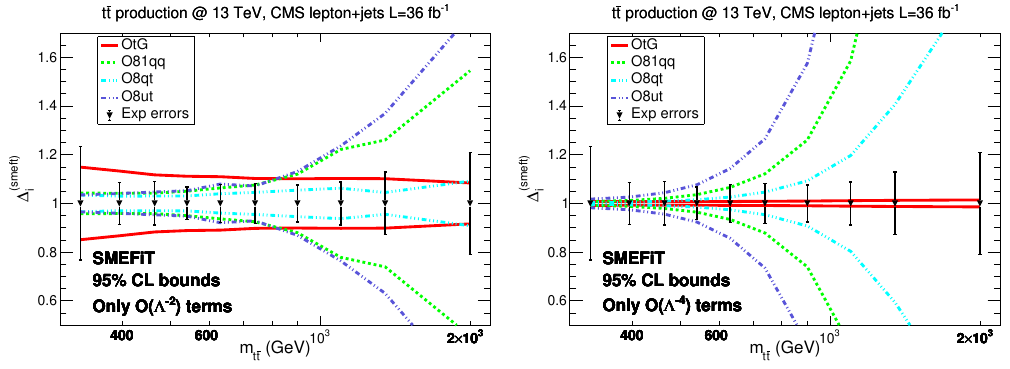
Figure 23 . The shifts induced by representative SMEFT degrees of freedom to the SM cross- sections, eq. (5.3), for the m distribution in the top quark pair production measurements at t (cid:22) t p s = 13 TeV from CMS, based on = 36 fb (cid:0) 1 and the lepton+jets channel [100]. We show the L shifts arising from the linear (left) and from the purely quadratic (right) terms. The shifts (cid:1) (smeft) have been computed assuming the 95% CL bounds (cid:14)c i of the baseline (cid:12)t reported in table 8. For reference, we also indicate the size of the corresponding experimental